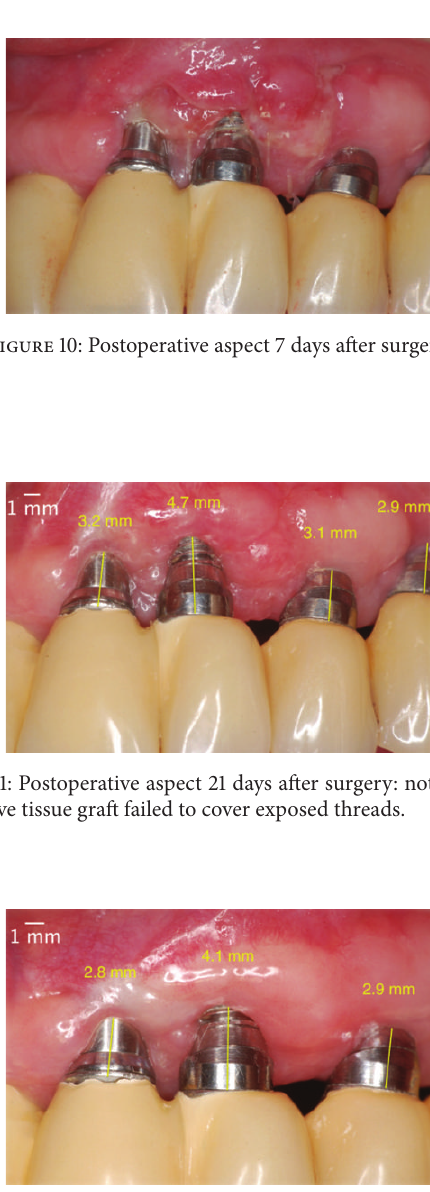
Figure 12: Postoperative aspect 90 days after the second surgery: presence of the phenomenon of “creeping attachment” with partial coverage of the implant’s threads.